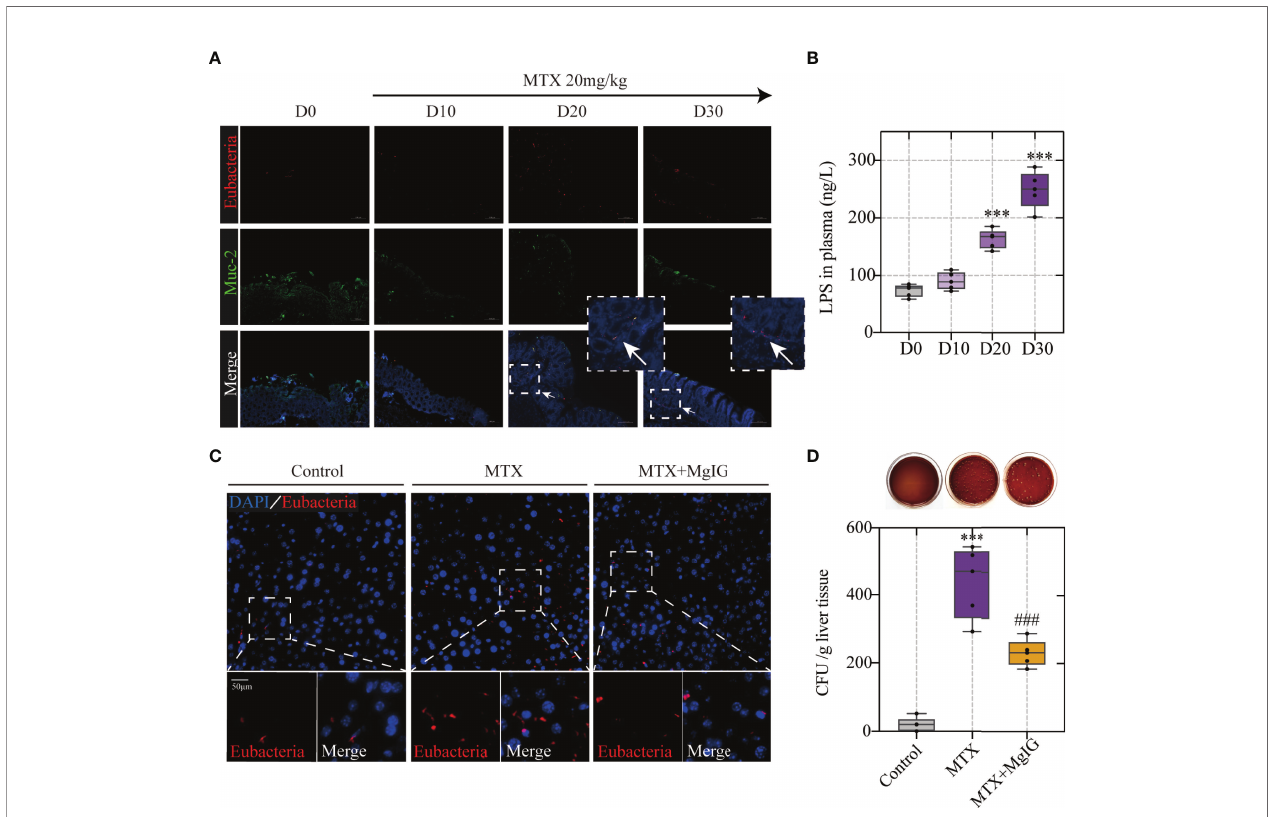
FIGURE 5 | Bacterial translocation is the prerequisite of MTX-induced hepatic lesion (A) Representative images of Fluorescent in situ hybridization of the colon at different timepoints. Arrows indicate detected bacteria. (B) Lipopolysaccharide concentration in plasma (n = 5, One-way ANOVA). (C) Fluorescent in situ hybridization of the liver (D) Counting of colony-forming units in liver tissue of each group (n = 5, One-way ANOVA). ***p < 0.001, compared with D0 or Control group. ### p < 0.001, compared with MTX